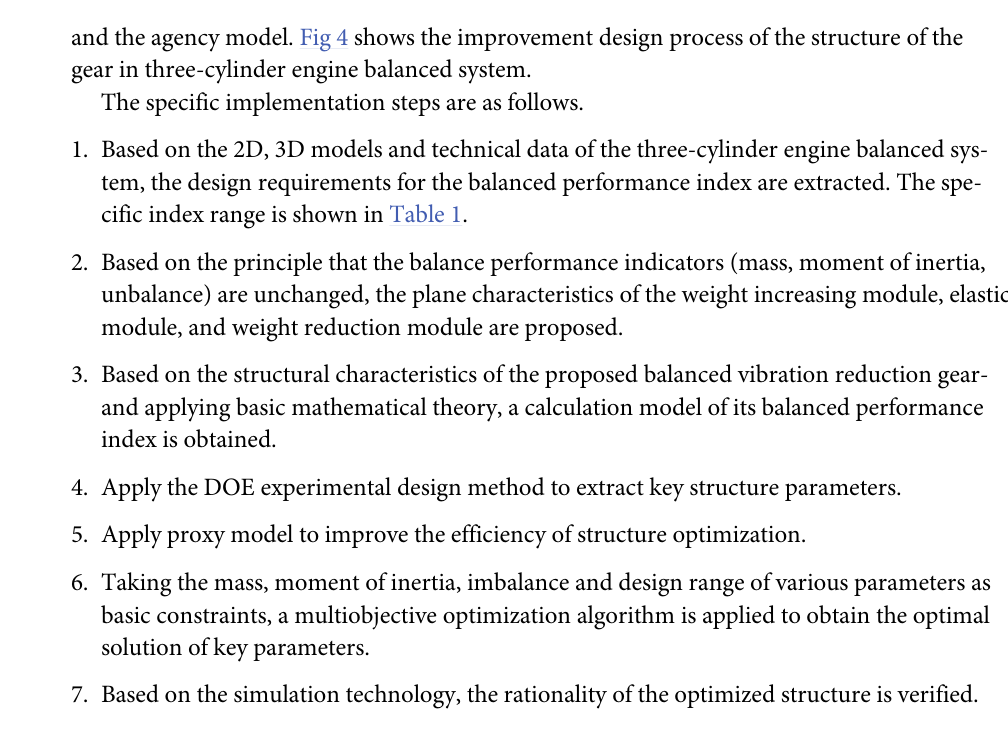
ffiffiffiffiffiffiffiffiffiffiffiffiffiffi p r 2 (cid:0) L 2 tan y þ L ð 1 Þ